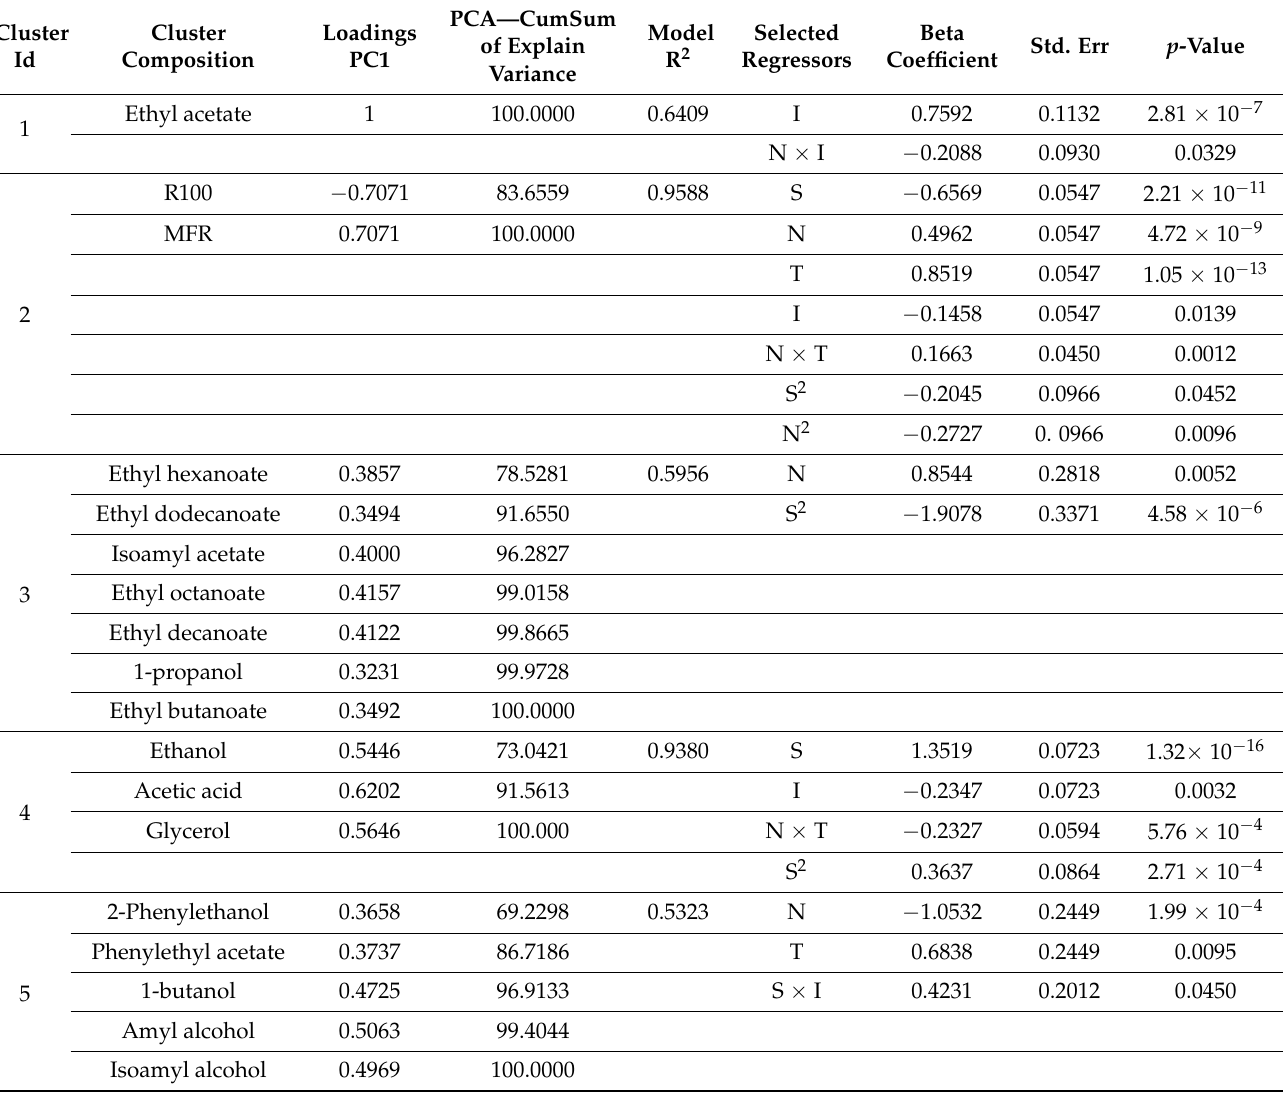
Table 3. Summary of results: modeling using main effects, 2nd-order interactions and quadratic